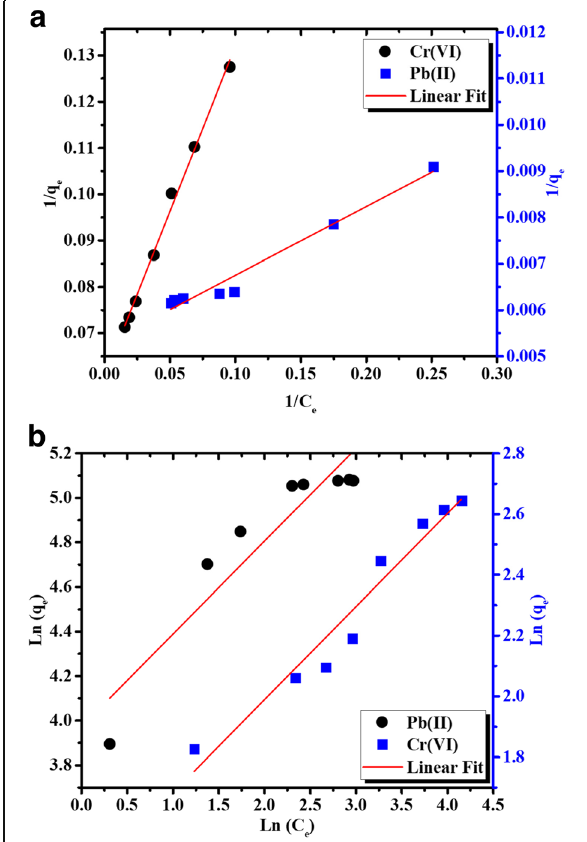
Fig. 8 Langmuir a and Freundlich b isotherms for Pb(II) and Cr(VI) adsorption onto CSM/SA hybrid